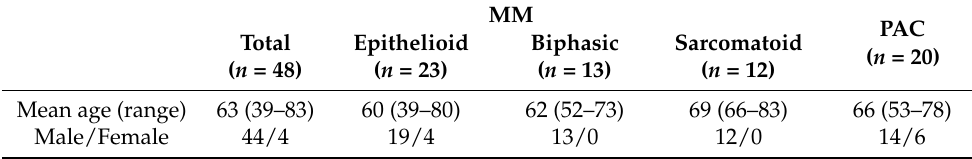
Table 1. Clinical characteristics in malignant mesotheliomas (MMs) and PACs.